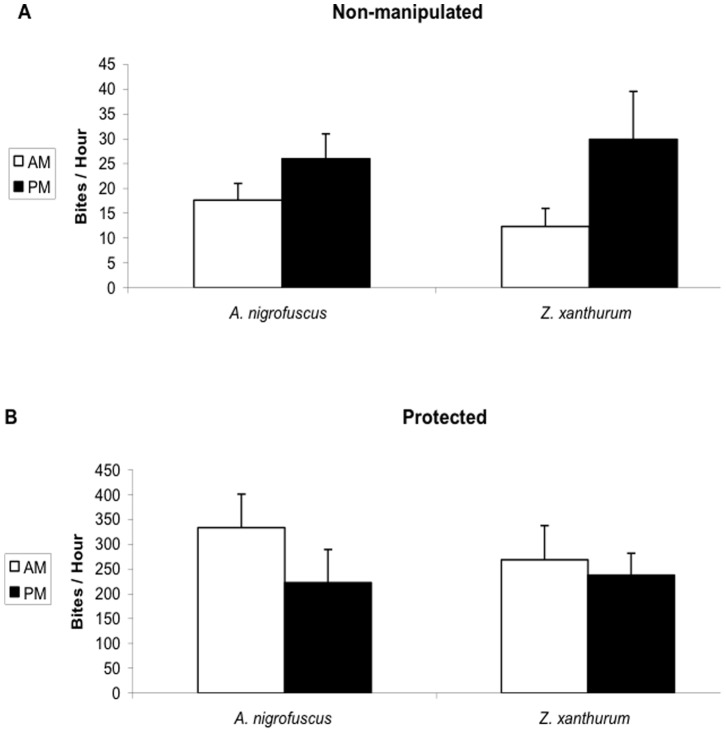
The diel feeding pattern disappears when the fish feed on algae grown protected from grazing.Average feeding rate (±SE) of A. nigrofuscus and Z. xanthurum on A non-manipulated and B protected plates measured 0.5–1.5 hr (AM, open bars) and 6–7 hrs (PM, full bars) after sunrise. Note the order of magnitude difference in scale between A and B, indicating the much higher bite rate on the protected plates.